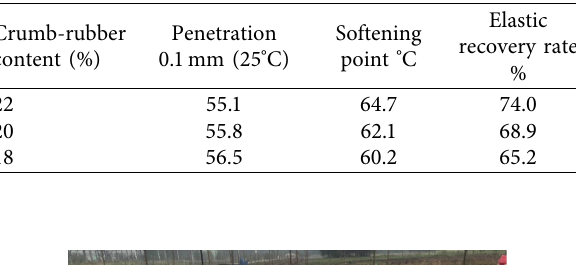
Table 1: Performance indexes of AR at three contents. Table 2: Surface free energy components of reagents [25].